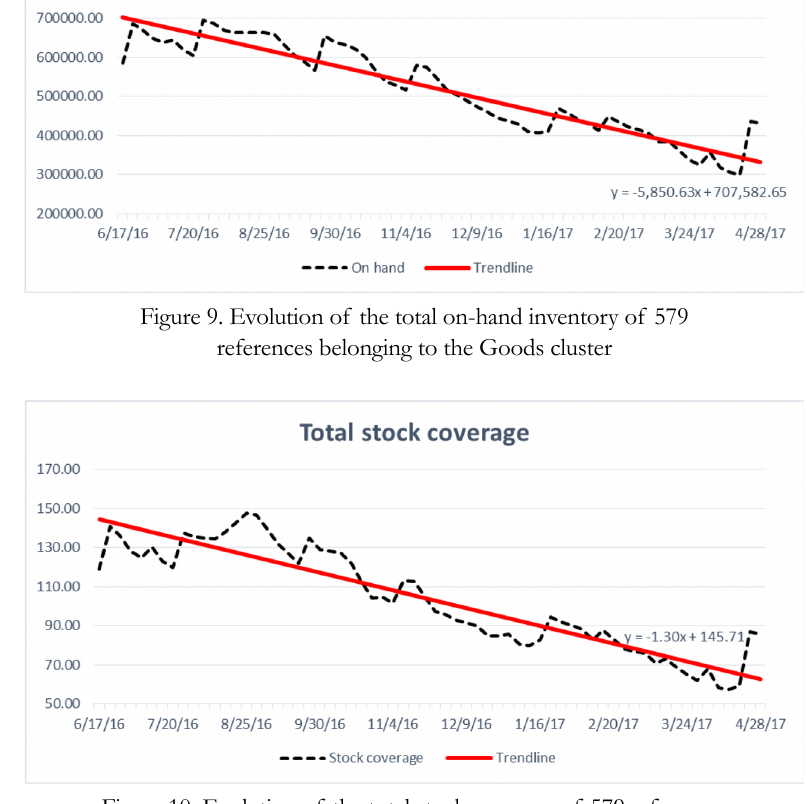
Figure 10. Evolution of the total stock coverage of 579 references belonging to the Goods